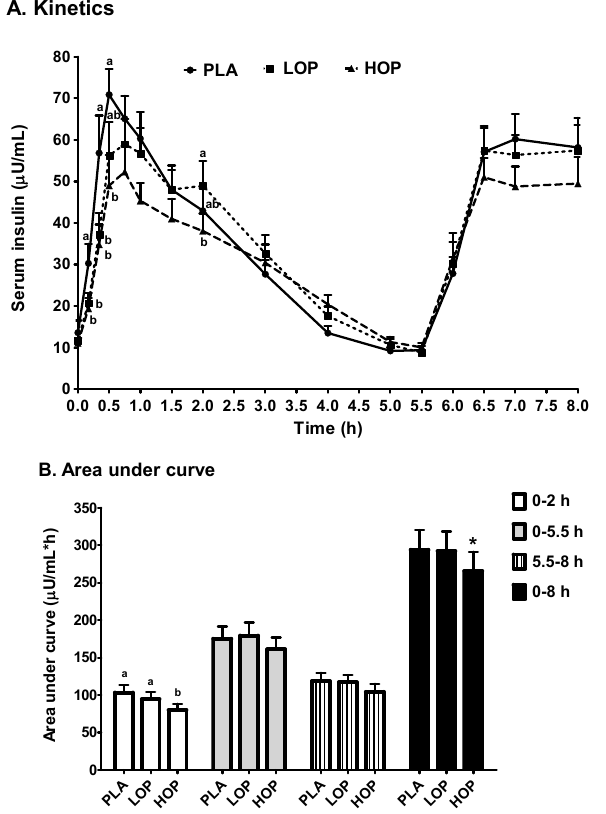
Figure 3. ( A ) Kinetics and ( B ) area under the curve of serum insulin in the subjects consuming one of three study beverages, placebo (PL), Low (LOP), and High (HOP) OP, along with a high fat, carbohydrate breakfast and a high fat, carbohydrate lunch after the 5.5 ‐ h blood draw. a,b Means at the same time point without sharing the same letter differ, tested by the general linear mixed effects model, followed by the Tukey HSD multi ‐ comparison test, p ≤ 0.05. * Means at the same period tend to differ from the other 2, p ≤ 0.1.